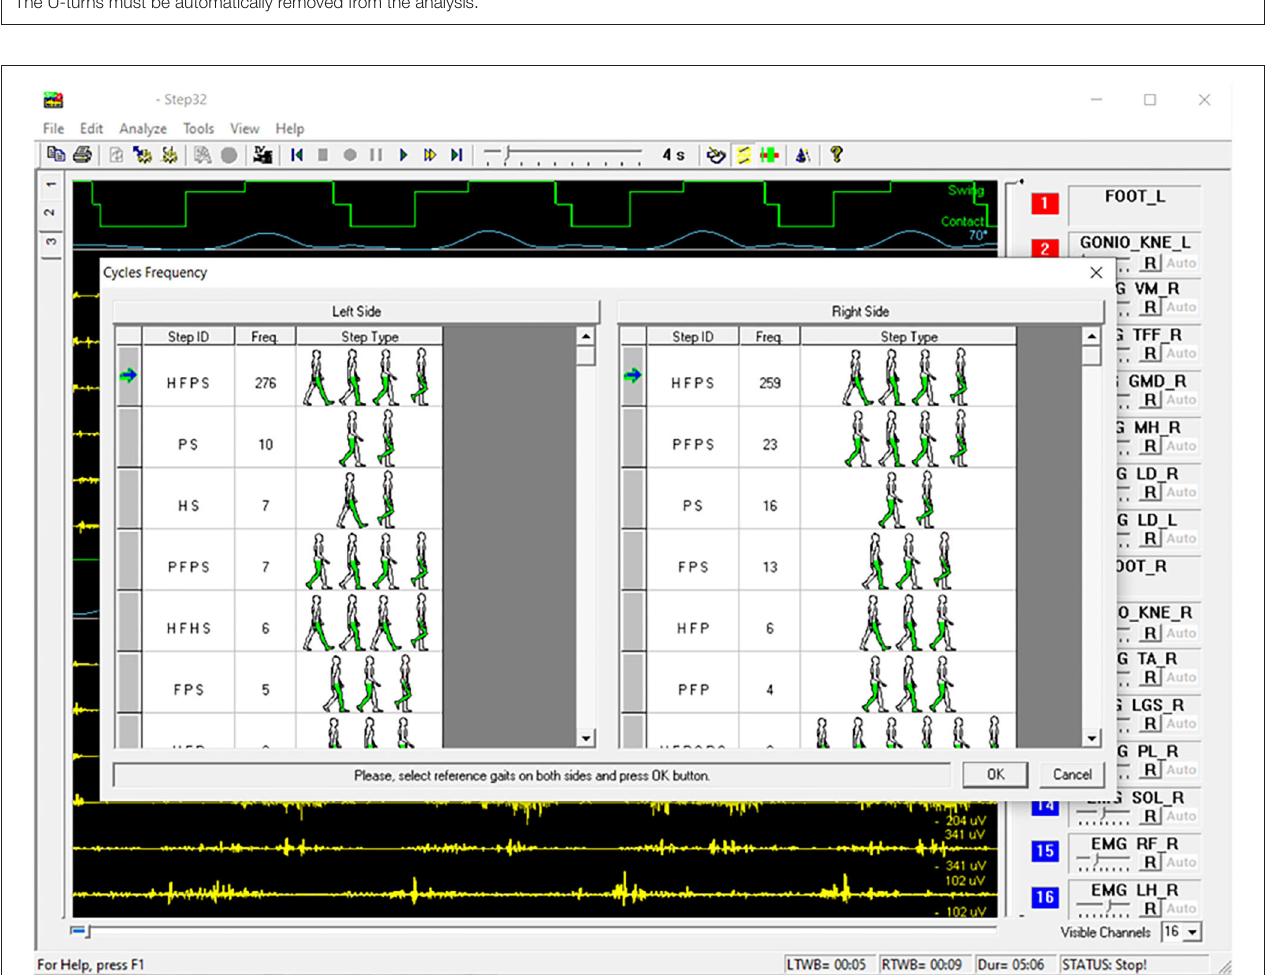
FIGURE 4 | Example of STEP32 interface showing the automatic segmentation and classification of gait cycles for a walk lasting 5:06min (Parkinson disease subject).